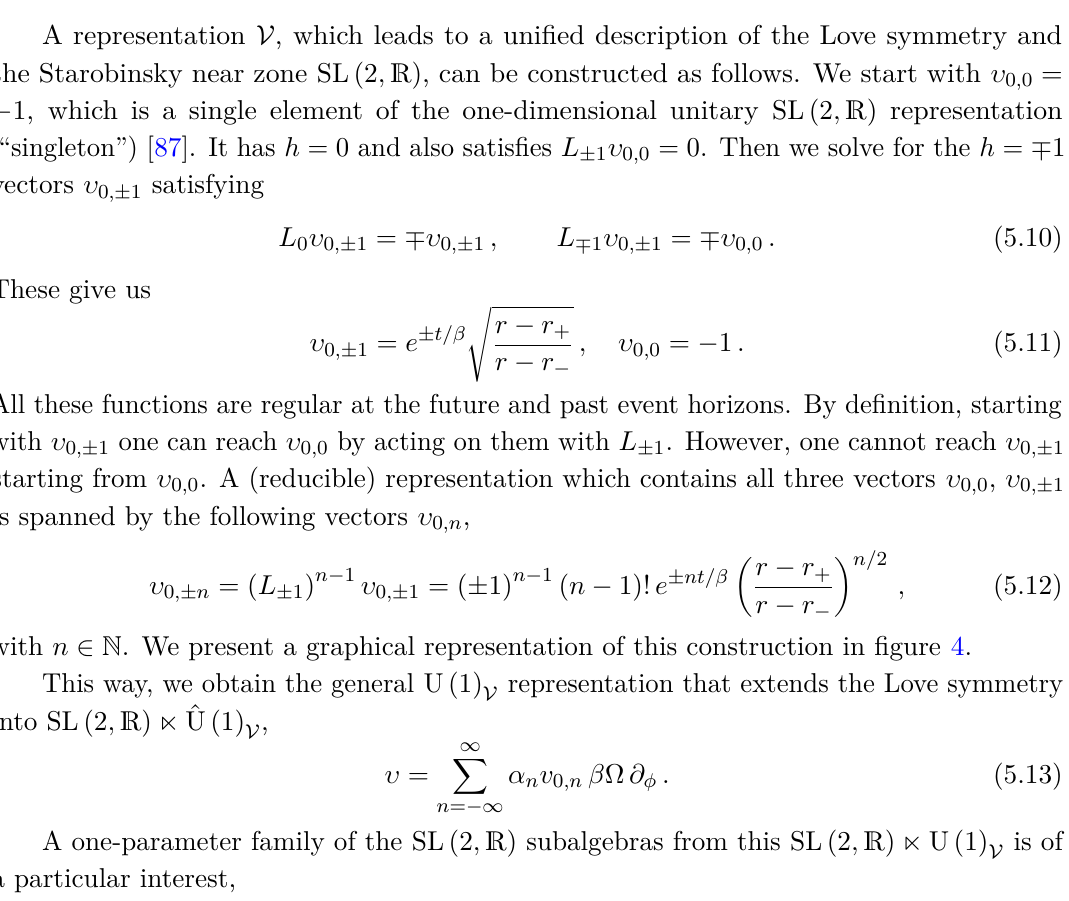
Figure 4 . A representation V of SL (2 , R ) used to construct the SL (2 , R ) n U (1) Love